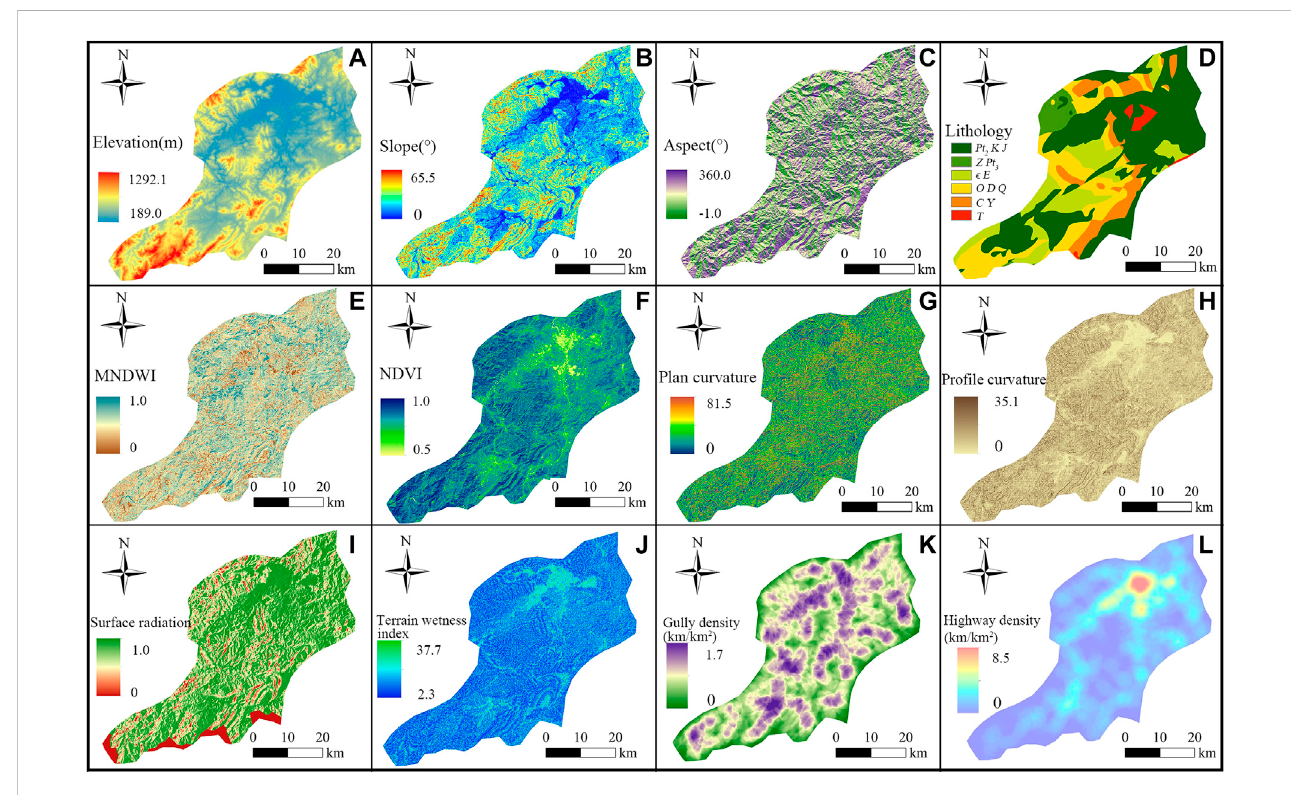
FIGURE 3 Partofthebasicenvironmentalfactorsof fl ash fl oodsinLongnan County: (A) Elevation, (B) Slope, (C) Aspect, (D) Lithology, (E) MNDWI, (F) NDVI, (G) Plan curvature, (H) Pro fi le curvature, (I) Surface radiation, (J) Terrain wetness index, (K) Gully density, (L) Highway density.